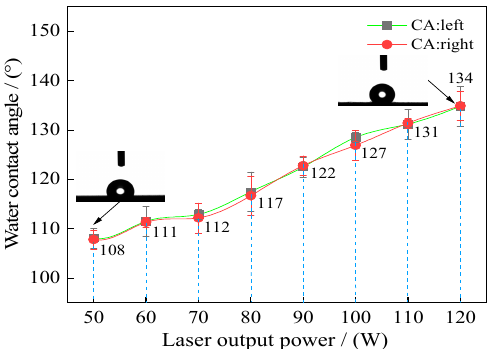
Figure 8. Water contact angle of textured surface with varying laser output power: ( a ) 50 W; ( b ) 60 W; ( c ) 70 W; ( d ) 80 W; ( e ) 90 W; ( f ) 100 W; ( g ) 110 W; ( h ) 120 W.